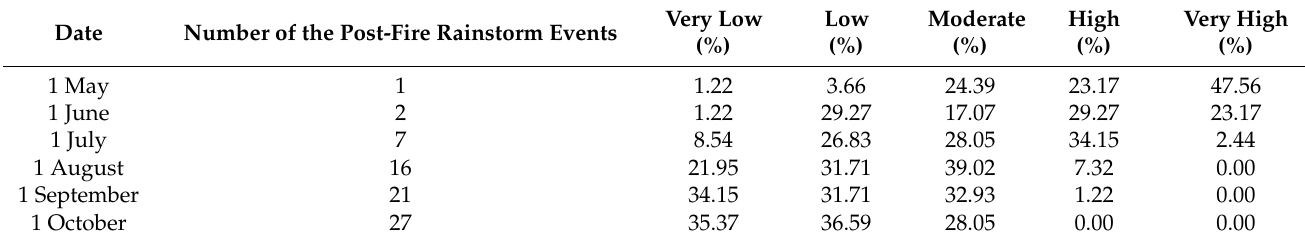
Table 6. Percentage of each PFDF susceptibility level in 82 watersheds in the study area in different post-fire periods.